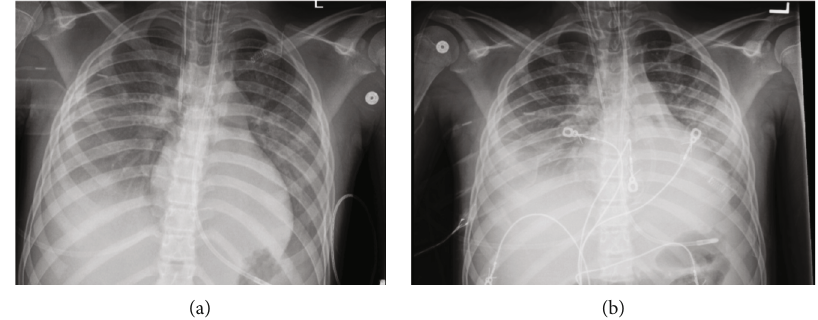
Figure 1: Chest radiograph one day prior (a) and at day of arrest